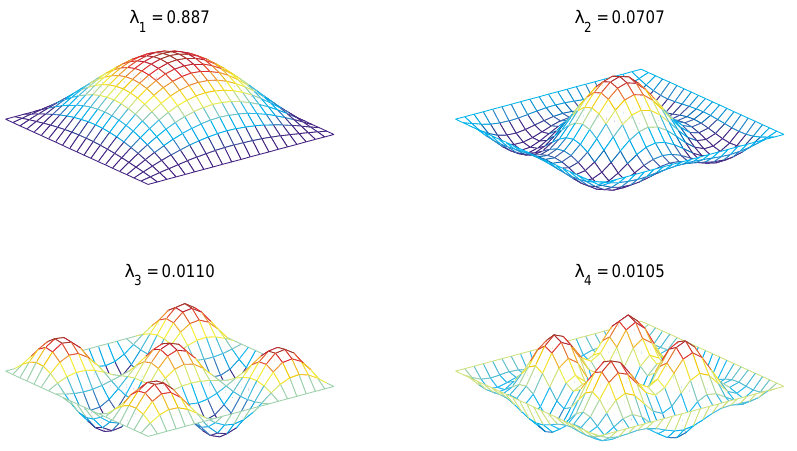
Fig. 15. POMs for square plate. Impulsive force applied at the center.